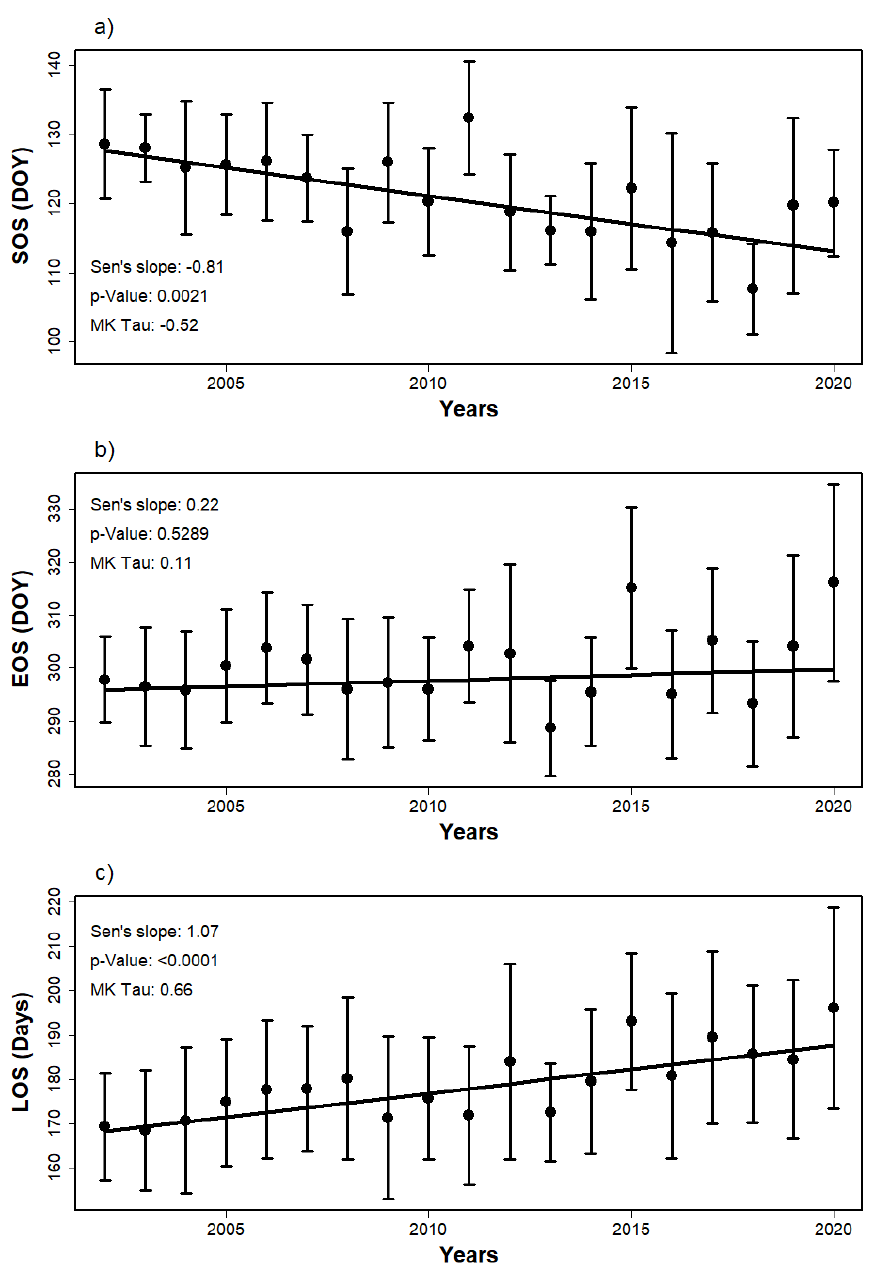
Figure 9. Trends of annual mean ( a ) SOS and ( b ) EOS dates, and ( c ) LOS over the study period (2002–2020) and their Sen’s slope estimations.